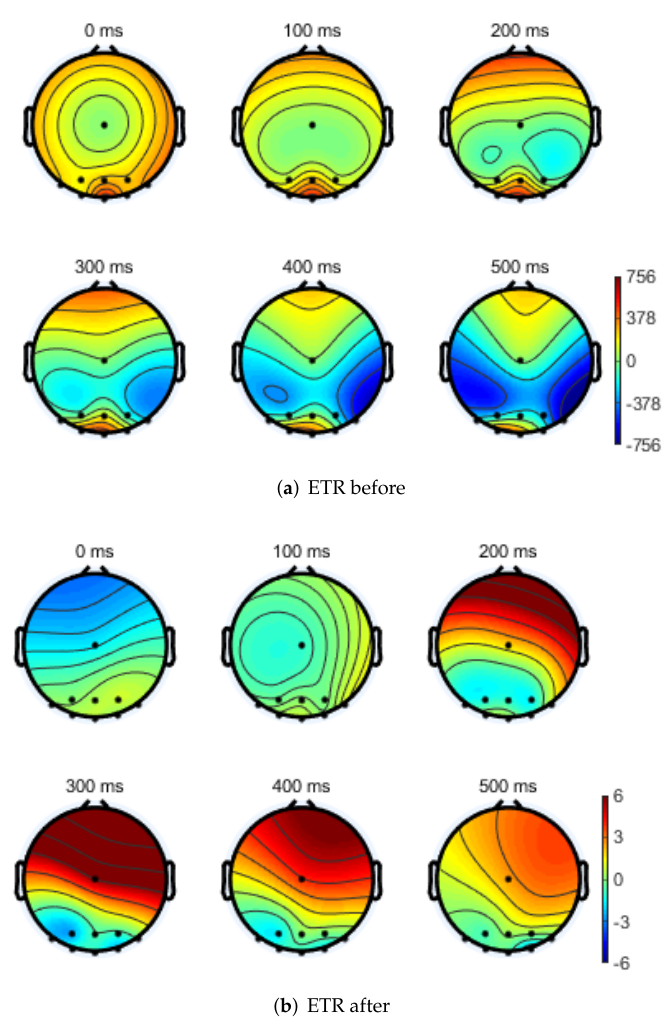
Figure 7. EEG topographical